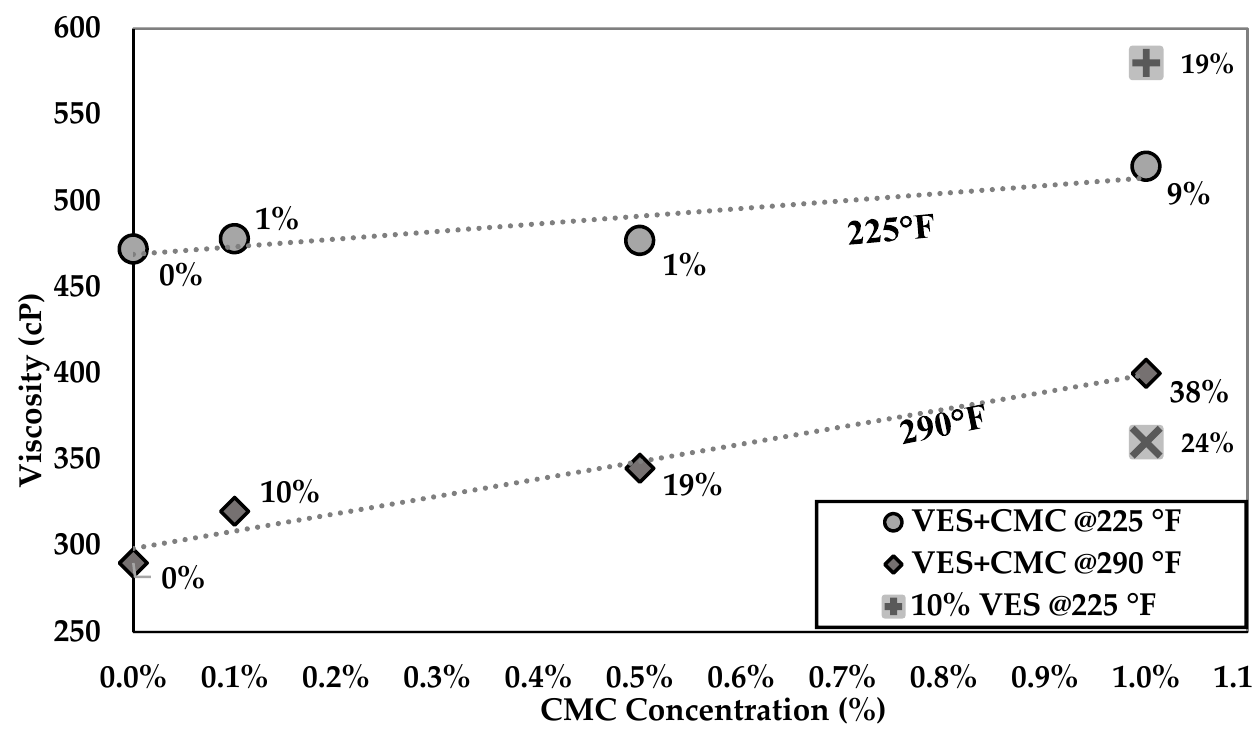
Figure 5. The increase of VES viscosity with different CMC concentration at the selected temperatures.